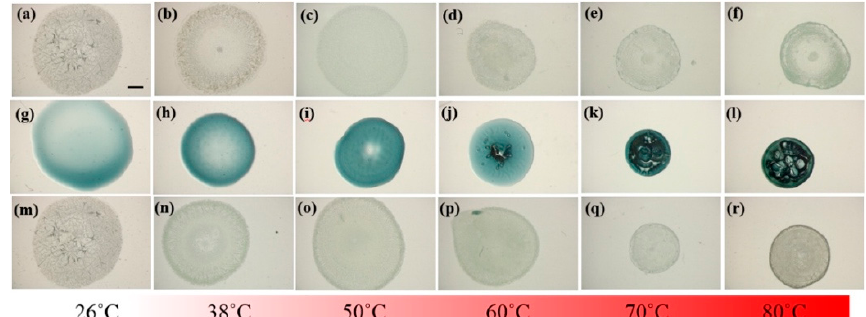
Figure 5. Large-area stereoscopic images of thermally treated ( a – f ) LAFs, ( g – l ) CsWO 3 NPs, and ( m – r ) their mixed nanocomposites are illustrated. The scale bar shown in ( a ) is 1 mm, applicable to all images in this